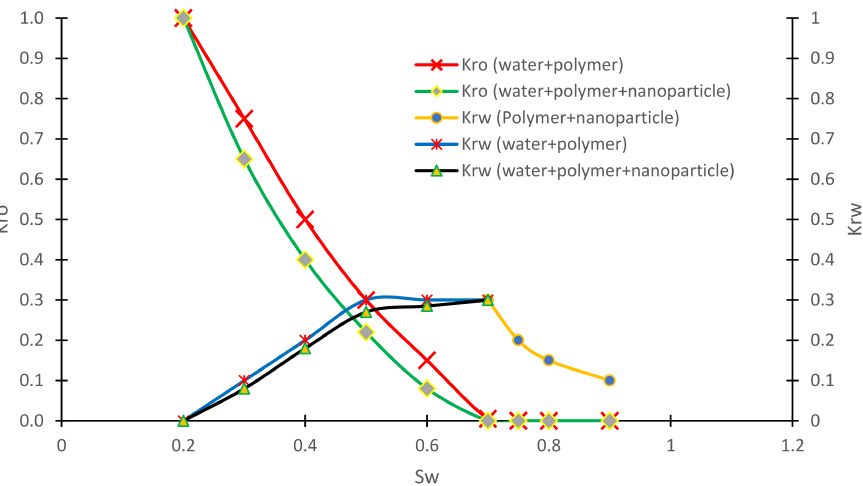
Figure 5. Relative permeability curves for water and polymer flooding in the presence of nanoparti- cles at reservoir temperature of 60 ◦ C and pressure of 1200